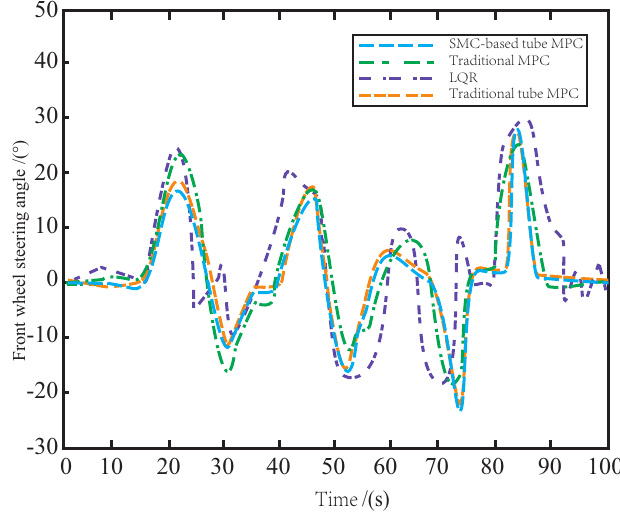
Figure 5. The variation of front wheel angle on the muddy